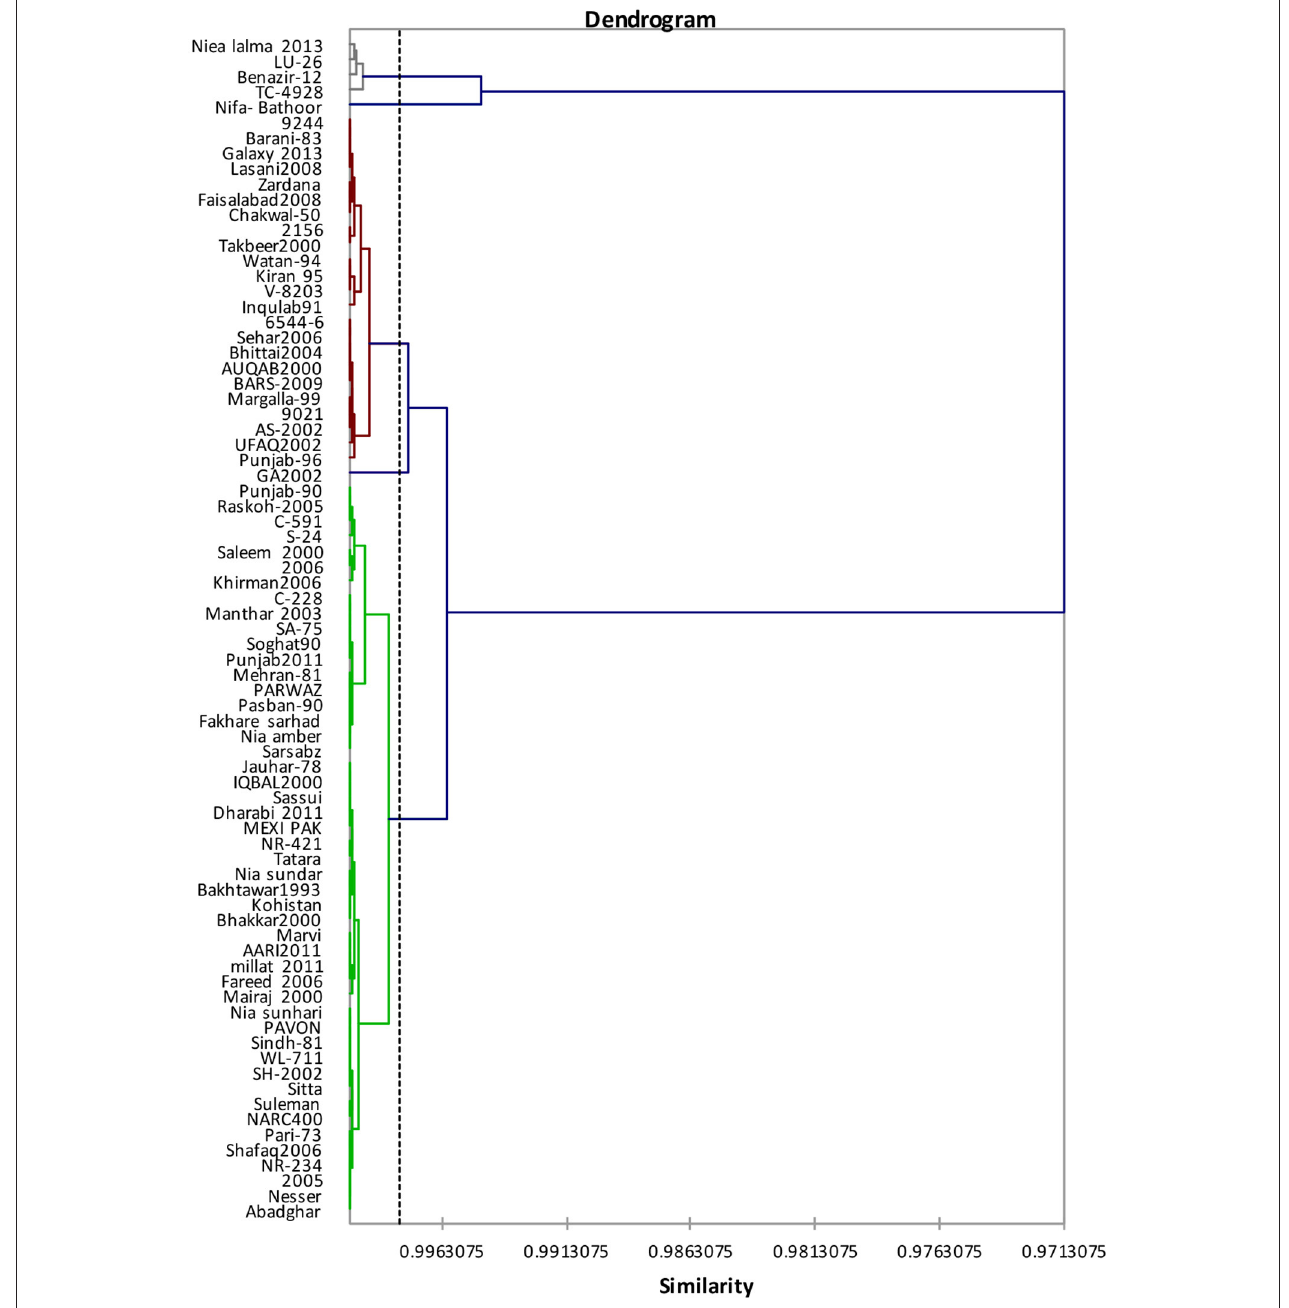
FIGURE 1 | Tree diagram based on four traits regarding single characteristics for different wheat